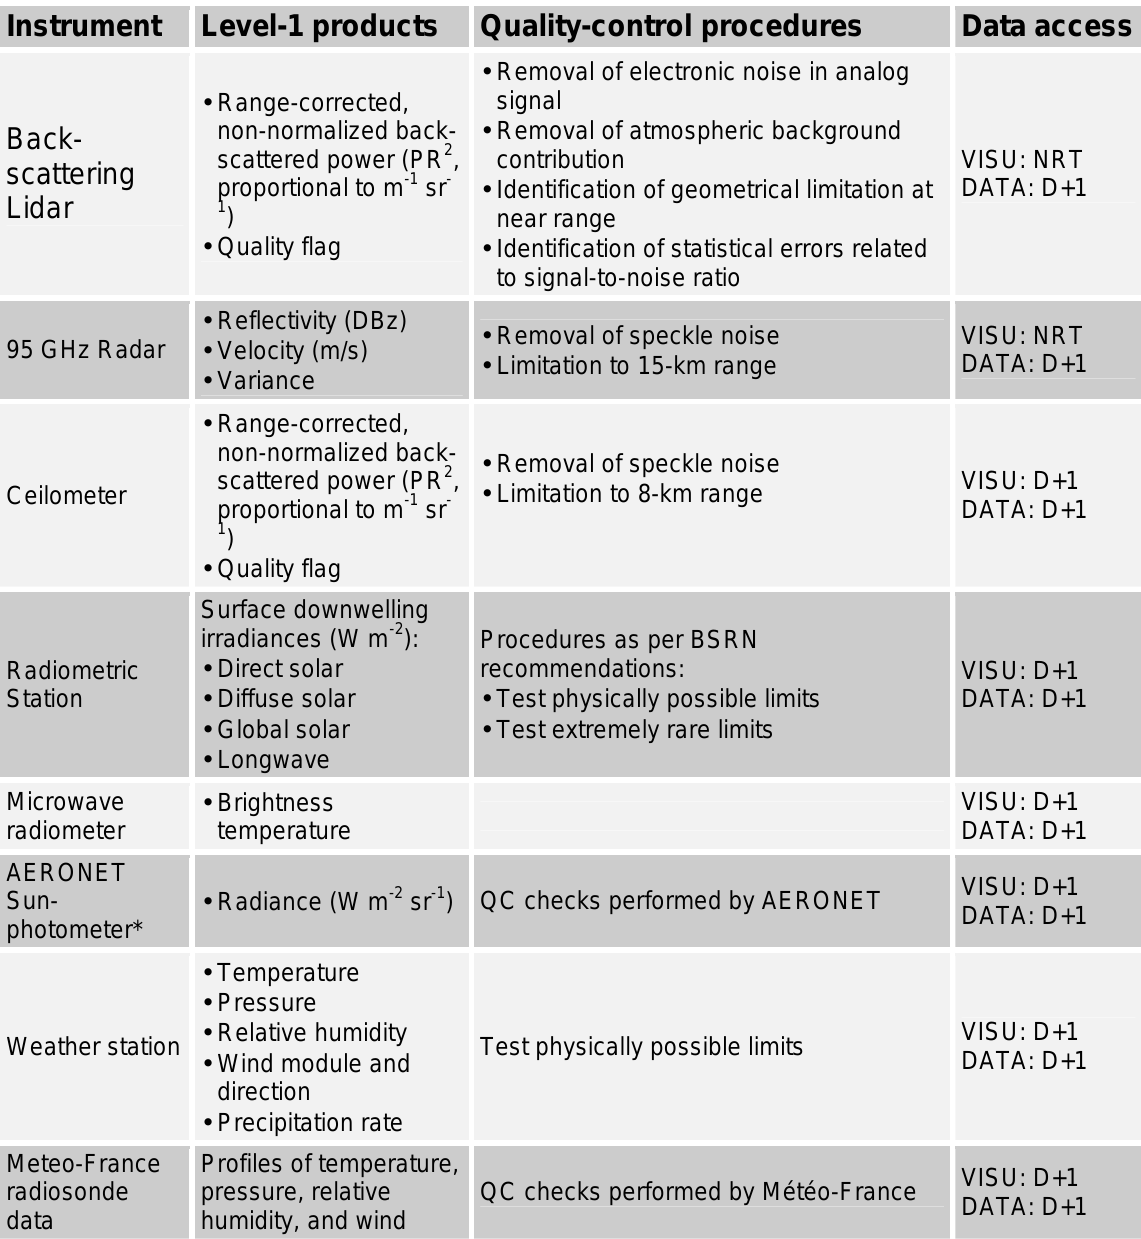
Table 4. Level-1 data accessible in the SIRTA archive. *Sun-photometer data should be retrieved directly from